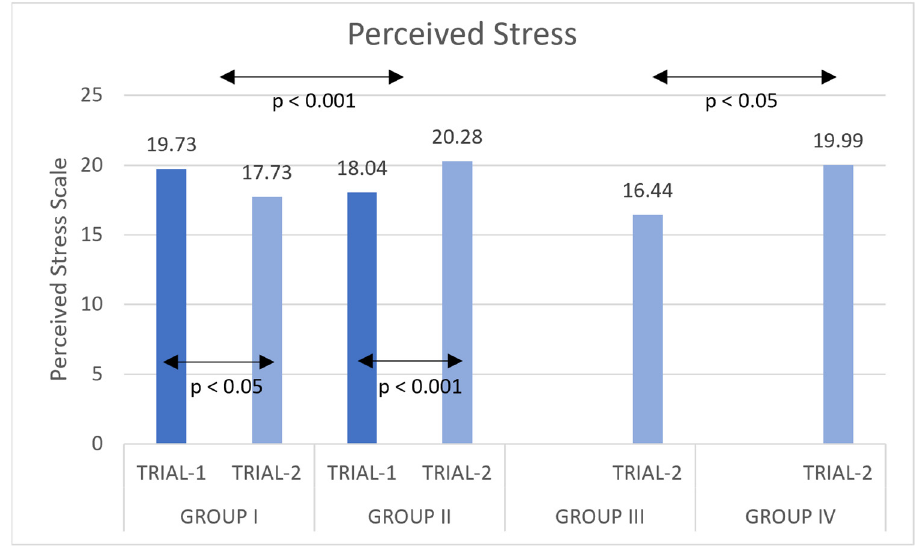
Table 7. Mean results for Perceived Stress Scale for Groups III and IV post-test measurements.